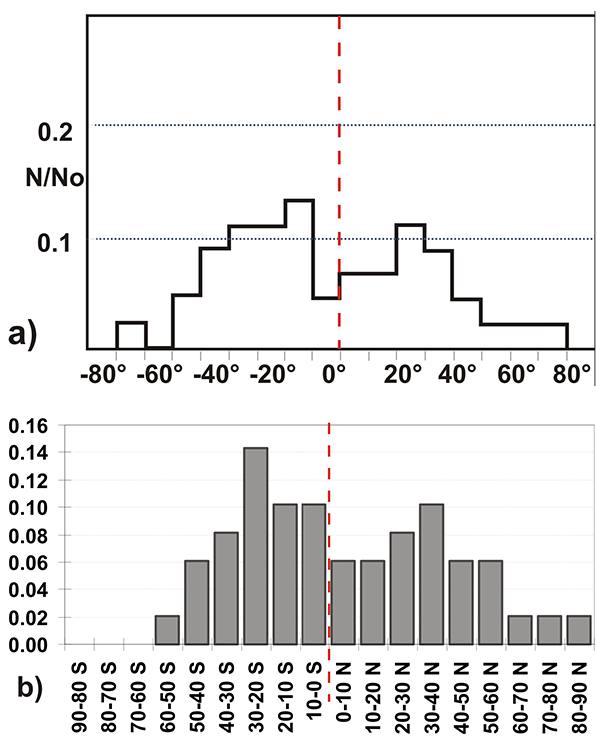
Fig. 7. The latitudinal distributions of the Earth hotspot relative numbers: fragment (a) adopted from the work of Stothers (1993); fragment (b) adopted from work of Courtillot et al. (2003). The horizontal axes show latitudinal belts (10 ◦ wide), vertical axes – relative number of the Earth hotspots. The red dotted vertical lines on both fragments correspond to the